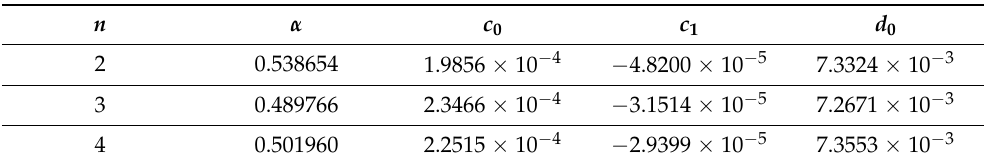
Table 3. The numerical calculation results of the undetermined constants c 0 , c 1 , α , and d 0 , where q = 1.725 × 10 − 6 MPa.